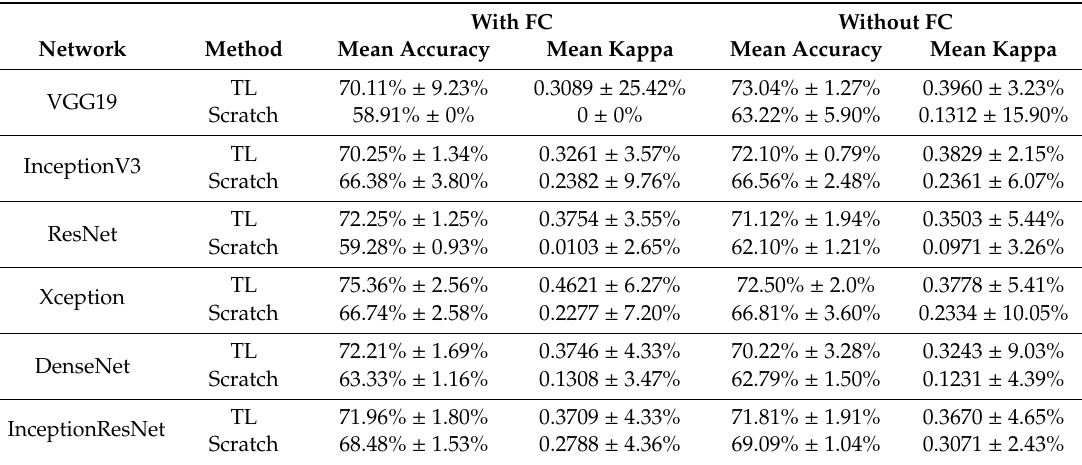
Table 4. Accuracy and Kappa scores of classifying hand images with and without fully connected layers ( ± 95%